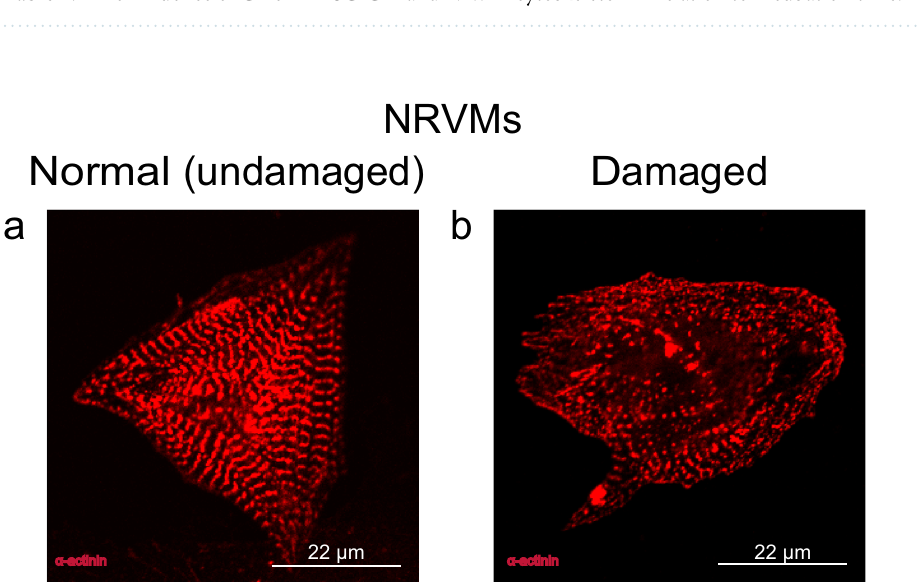
Figure 7. Representative image of α-actinin damage in isolated NRVMs under the influence of CP. ( a ) Normal, undamaged cardiomyocyte. ( b ) Cardiomyocyte with damaged α-actinin after incubation with 213 µM (~ 4 mg/ kg) of